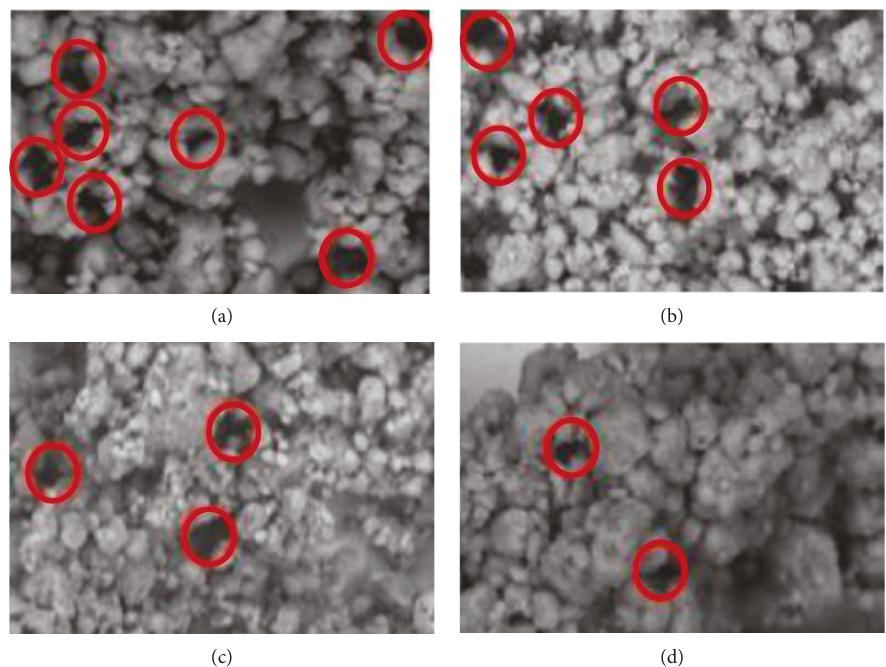
Figure 6: Morphology of 2500x magni fi cation DSSC in various clathrin percentages: (a) 0%; (b) 25%; (c) 50%; (d)